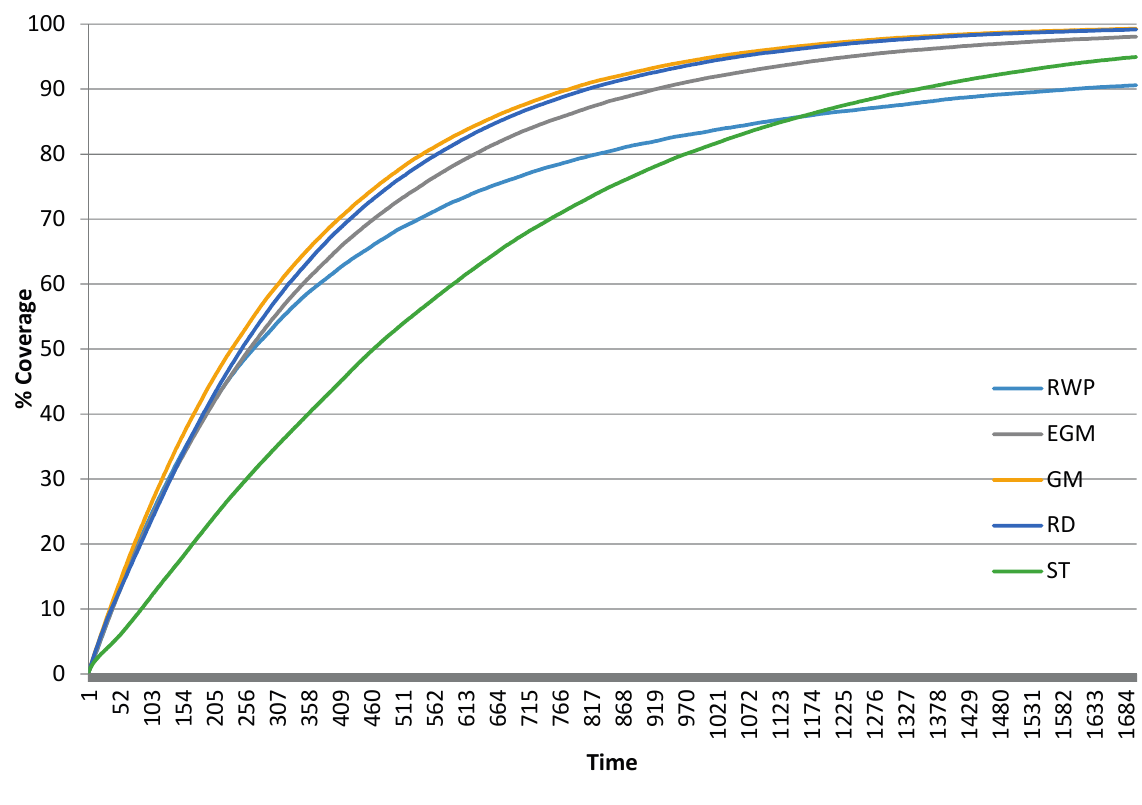
Figure 6. Coverage for the various mobility